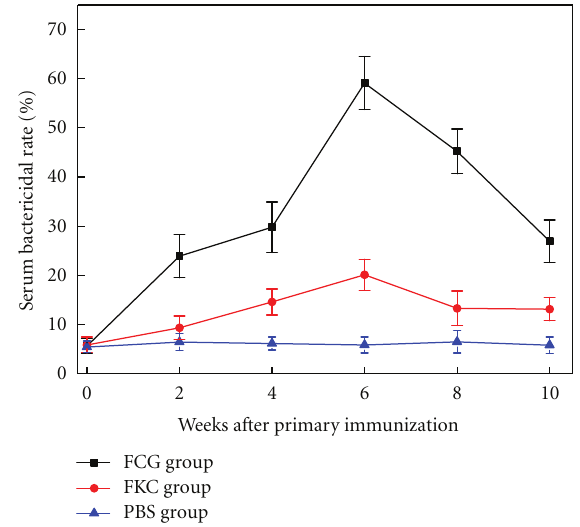
Figure 4: Serum agglutination titres of fish vaccinated with FCG and FKC at di ff erent time points postprimary immunization. Grass carp were vaccinated with FCG or FKC via intraperitoneal injection with a boost at 4 weeks after primary immunization. Serum agglutination titres represent the highest dilutions that gave rise to positive reaction. The titres of FCG group were significantly higher than FKC group at all the examined time points ( P < 0 . 01).